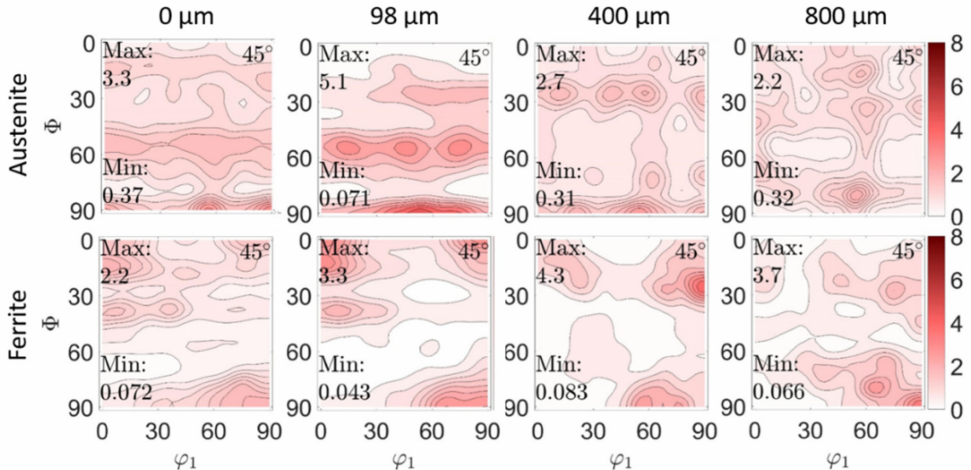
Figure 7. Crystallographic texture of the austenite and ferrite phases for the duplex stainless steel 1.4462, and evolution of the phase-specific texture in depth for the work hardened state (after deep rolling). The presented selected depths correspond with different degrees of work hardening. The initial texture is displayed in Figure 3. The color code on the right corresponds to the texture sharpness